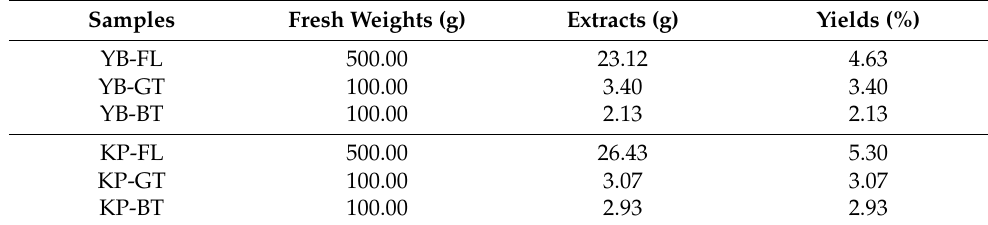
Table 3. Weights and yields of mulberry leaf